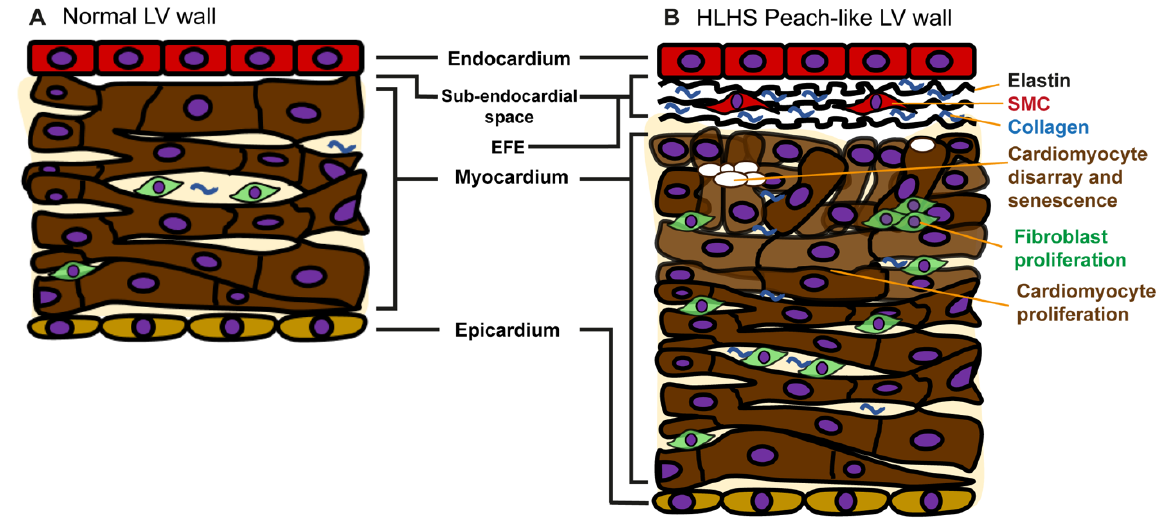
Figure 3. Cartoon showing changes found in HLHS peach-like left ventricular wall. ( A ) In the normal left ventricular (LV) wall the sub-endocardial space is not prominent, and cardiomyocytes are organised in parallel fibres. Between the cardiomyocytes there are fibroblasts ( green ) and there is also diffuse collagen deposition ( blue ). ( B ) In the peach-like LV wall seen in hearts with both MS/AA and MS/AS, the sub-endothelial space is enlarged and there are prominent elastin fibres ( black ) with increased collagen deposition ( blue ). There are also smooth muscle cells (SMC; red ), which are considered to derive from the endothelium. The myocardium close to the lumen has marked disarray and there are vacuolated cells. There is more collagen deposition in this area. Towards the epicardial side of the LV wall the cardiomyocytes appear more normal and normally organised. Overall, the LV wall appears thickened, and this may be due to cardiomyocyte hyperplasia, fibroblast proliferation or more extracellular matrix deposition or a combination of these changes.